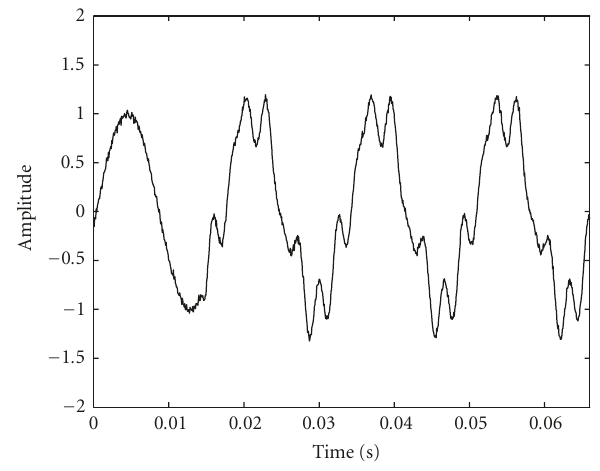
Figure 16: Harmonic disturbance associated with vector h .